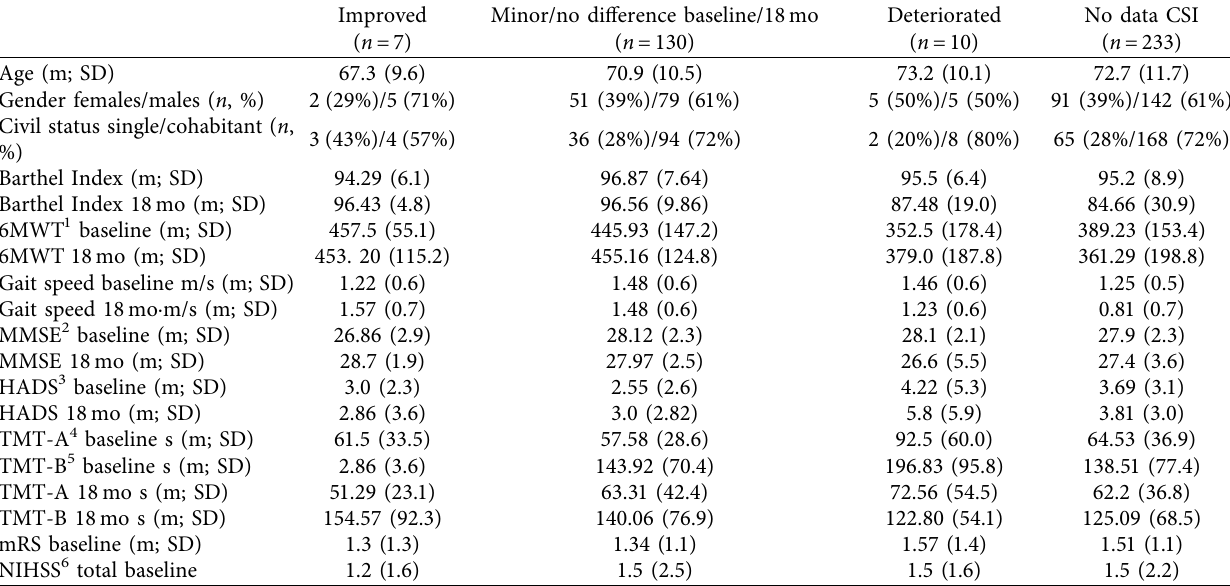
Table 1: Baseline demographic and clinical characteristics in mean (m) and standard deviation (SD). In persons with stroke divided into groups of reported change in Caregiver Strain Index (CSI), in frequencies ( n ) and percentages (%), between 3 and 18